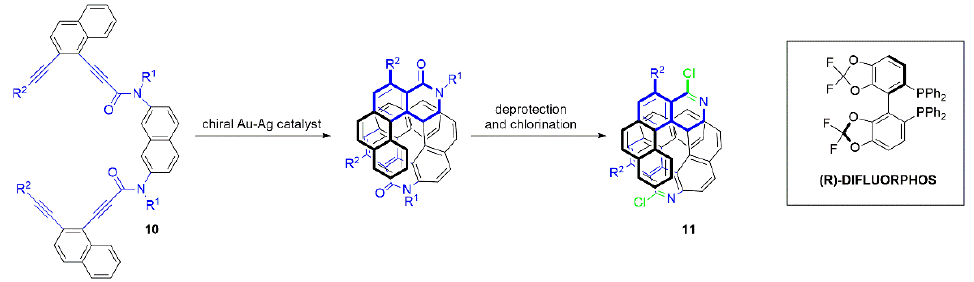
5 of 29 Figure 5. Gold-catalyzed asymmetric intramolecular hydroarylation of available ortho-alkynyl-fer- rocene derivatives ( 8 ) together with the structure of the best selected catalyst. As mentioned before, the asymmetric gold catalyzed hydroarylation turned out to be a very useful method for the enantioselective synthesis of helicenes. In 2016 the group of Tanaka exploited the gold-catalyzed intramolecular quadruple hydroarylation of a tetrayne for the enantioselective synthesis of an aza[10]helicene ( 11 ) [20]. Screening of ax- ially chiral biaryl bisphosphine ligands revealed that the gold(I) complex obtained from AuCl(SMe 2 ) and the electron-deficient difluorphos ligand was the best system for achiev-